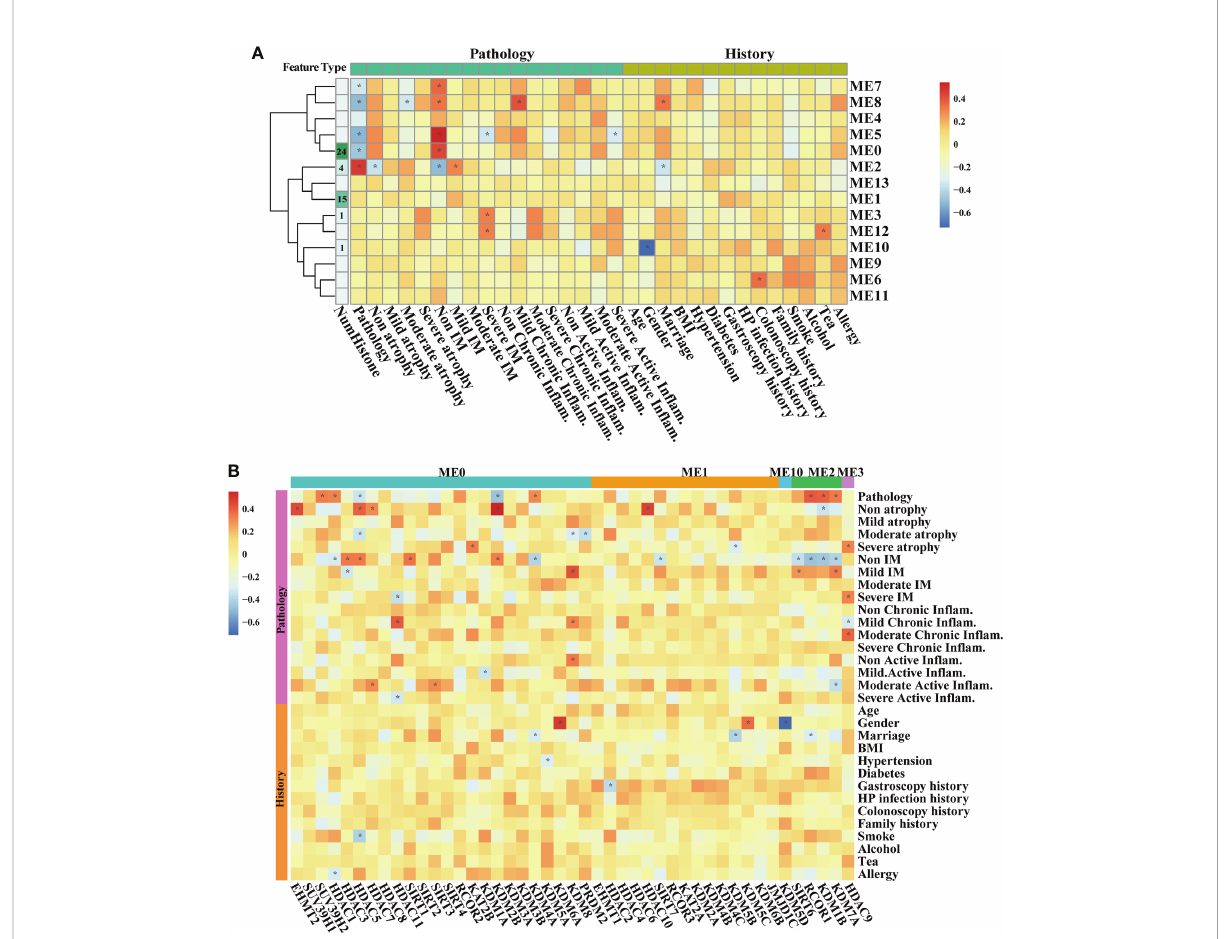
FIGURE 3 WGCNA on all samples based on bulk RNA-seq transcriptomes. Heatmaps illustrating modules – trait relationships (A, B) HMGs – trait relationships. The trait data were composed by diagnosis features in pathological sections, and previous history. The module af fi liations of HMGs were labeled by the color bars on the top of the column. The symbol * means FDR adjusted p value for the labeled correlation was less than